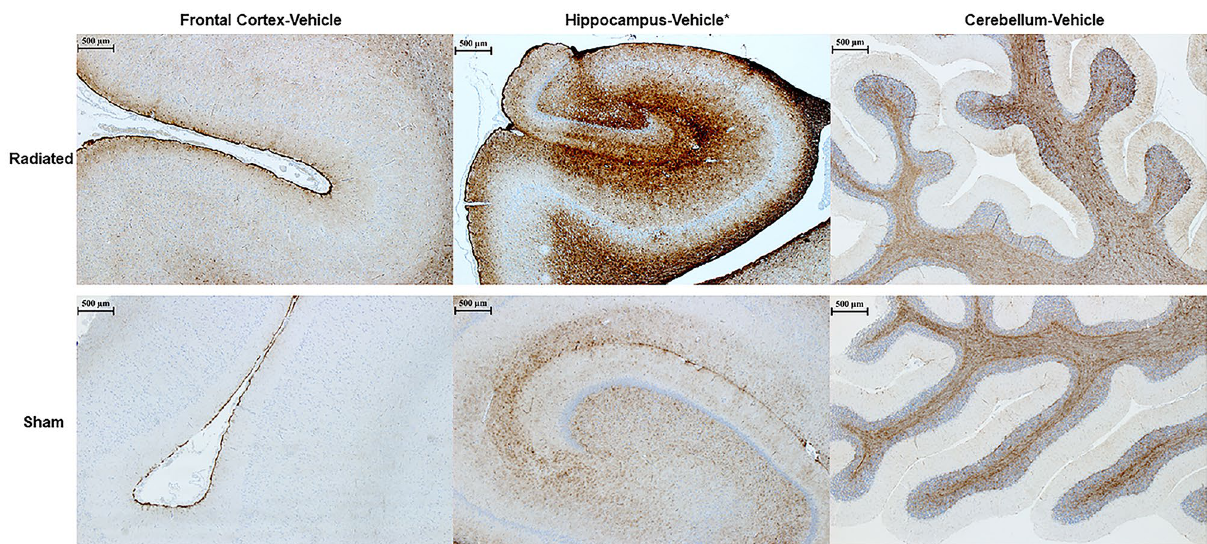
Figure 6. GFAP Immunohistochemistry across Different Regions of Swine Brain after 4 weeks following low- dose post-radiation. The figure shows Frontal Cortex, Hippocampus and Cerebellar Cortex of a Radiated and a Sham vehicle treated animal immunostained for glial fibrillary acidic protein (GFAP), a marker for astroglial cells. *To notice the presence of the astroglial response in the Hippocampus (H), specifically in the peri-dental gyrus area, of the Radiated versus Sham animal. The digital photographs were taken using a bright-light microscope (Zeiss ImagerA2) with a 20 ×